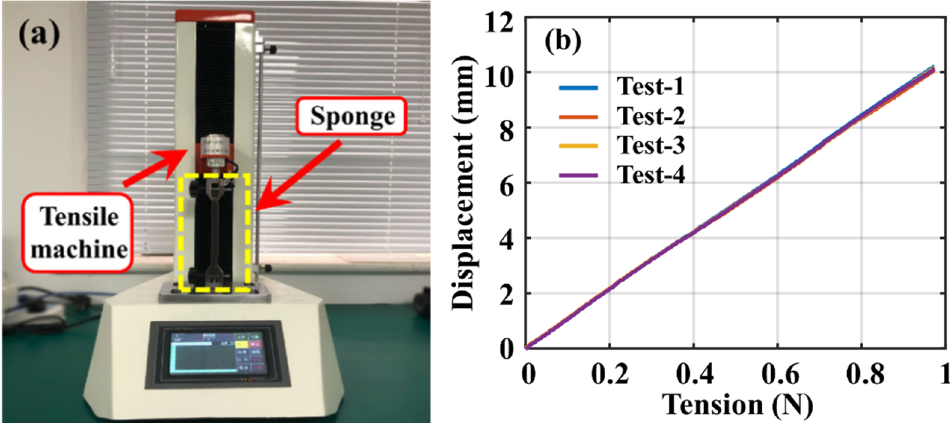
Figure 4. Measurement of the sponge parameters. ( a ) Tensile machine; ( b ) Mechanical properties of the sponge.